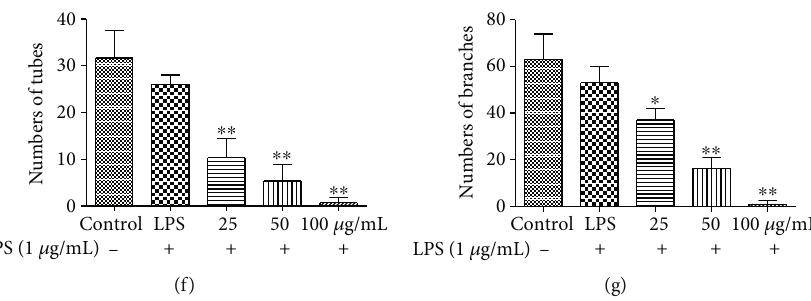
Figure 2: EECP suppressed migration, invasion, and colony formation in MDA-MB-231 cells stimulated with LPS. (a) EECP suppressed migration, invasion, and colony formation in MDA-MB-231 cells. (b) – (d) Quanti fi cation of cell migration, invasion, and colony formation in MDA-MB-231 cells after EECP treatment. (e) EECP inhibited angiogenesis in human umbilical vein endothelial cells (HUVECs) at 6h. (f, g) Quanti fi cation of tubes and branches of angiogenesis. Values represent the mean ± SEM from three independent experiments ( ∗ P < 0 : 05 , ∗∗ P < 0 : 01 vs. control, n = 3 ).